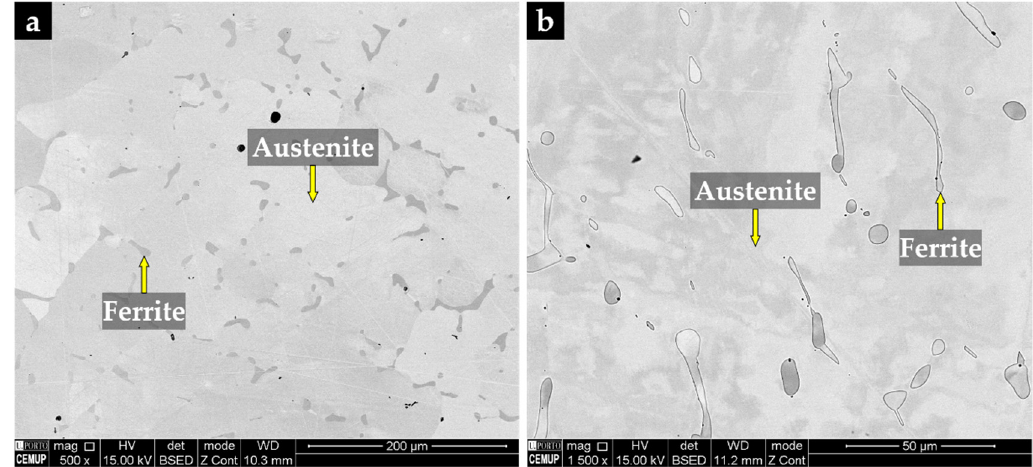
Figure 10. SEM image of the austenitic stainless steel after solution heat treatment at 1075 °C/2 h ( a ) and the same after chemical etching with 10% oxalic acid and higher magnification ( b ).